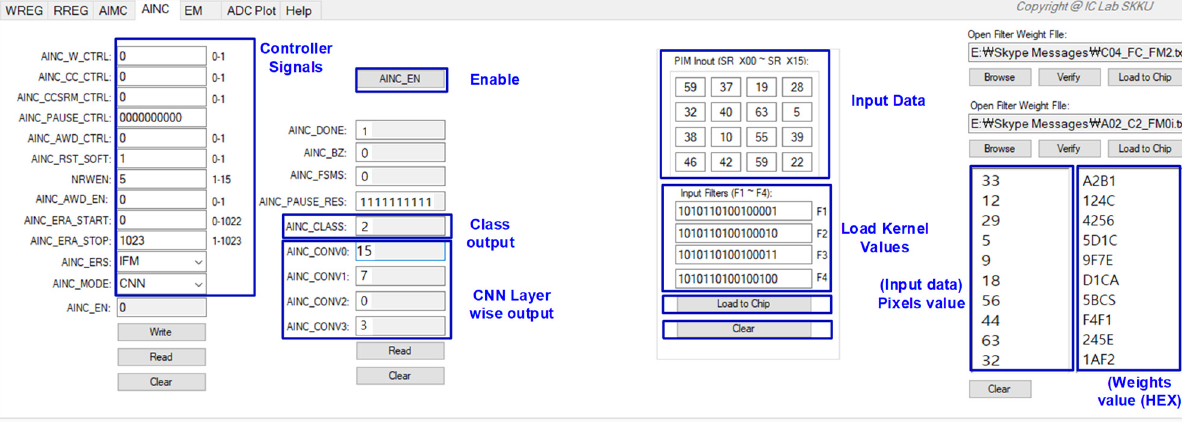
Figure 12. A customized GUI for testing.